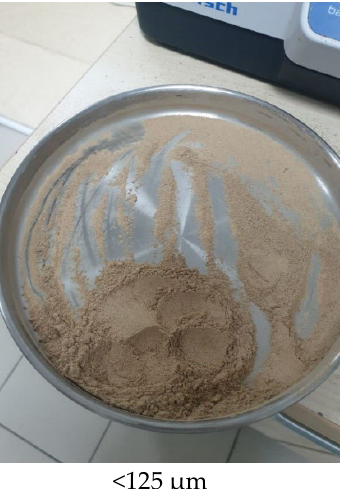
Figure 5. Types of granulosity.